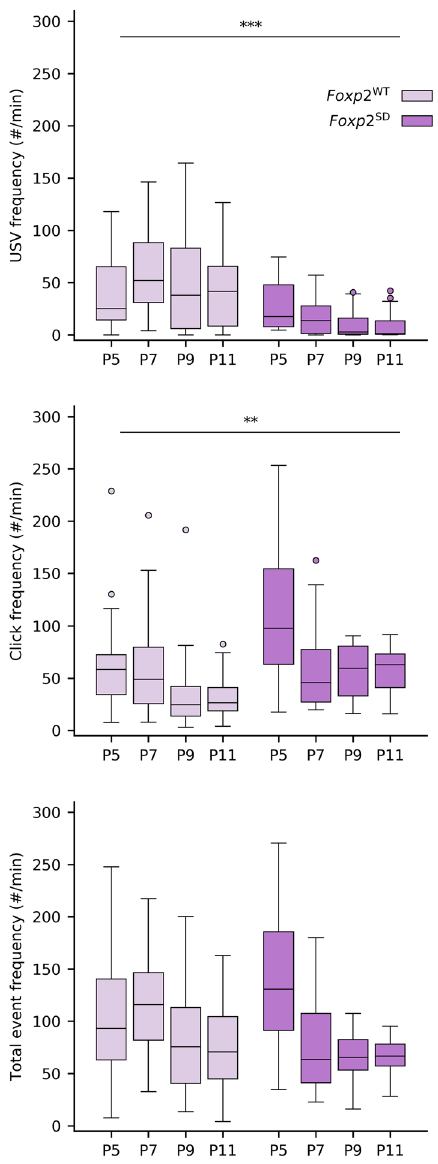
Figure 3. USV and click rates are affected in Foxp2- SD mice compared to WT mice, whereas the total event rate is mostly unaffected. Top: the USV rate is significantly reduced in the Foxp2 -SD mice, consistent with established literature on pup USVs in mice with Foxp2 disruption. Middle: Click rates are significantly increased in the Foxp2- SD mice. Bottom: comparing the sum of both USVs and clicks between the WT and Foxp2- SD mice only shows a difference at P7. Significance: * p < 0.05; ** p < 0.01; *** p <